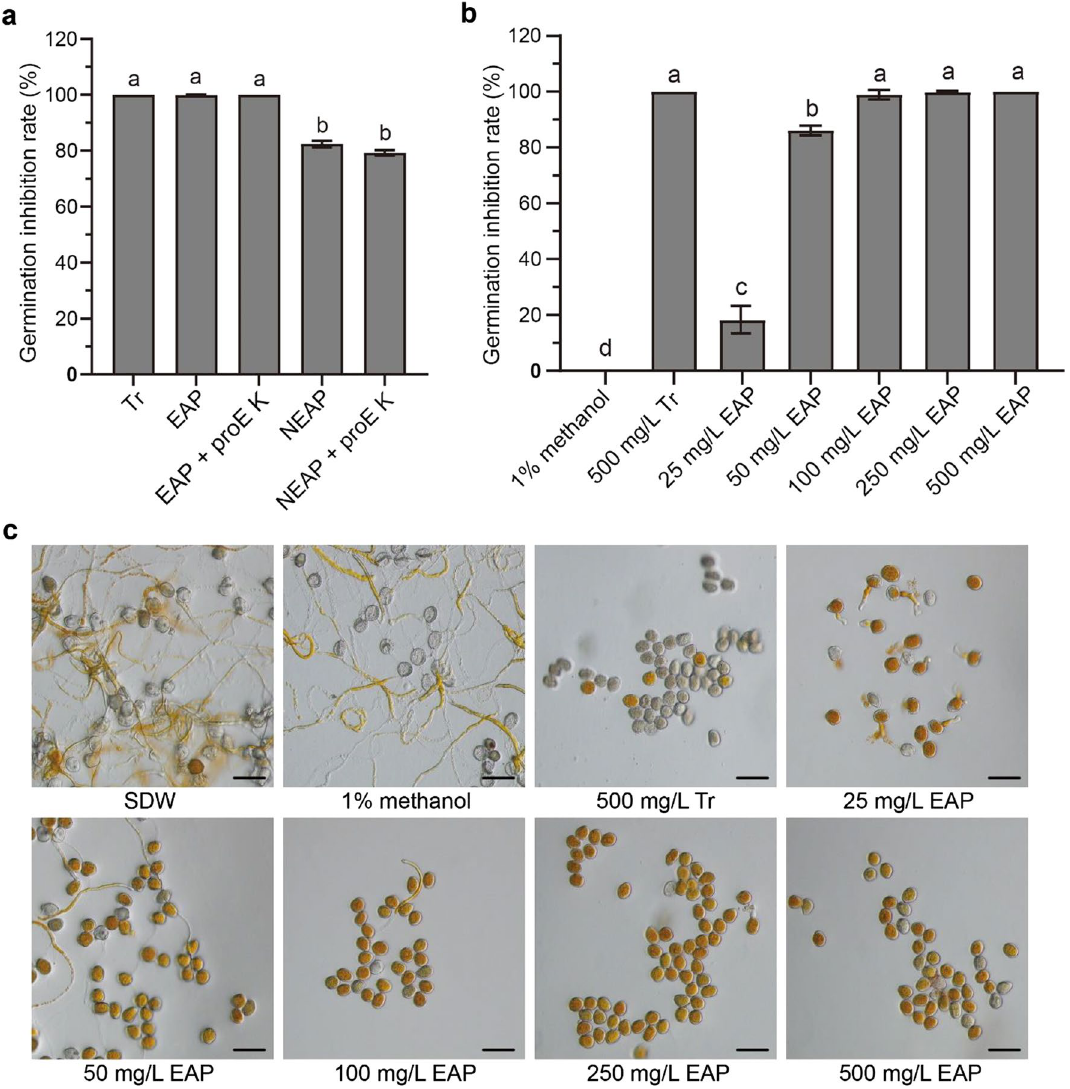
Fig. 6 Effect of different concentrations of EAP solution on the germination of Pst urediniospores. a Comparison of the inhibition rate of urediniospore germination by EAP and NEAP before and after treatment with proE K. Values in the chart are mean range tests, different lowercase letters indicate differences with significance level 0.05. b Inhibition rate of urediniospore germination by incubating with different concentrations of EAP solution for 12 h at 9°C in the dark. c Morphology of urediniospores in the above treatments under the optical microscope. Bars 50 μm. EAP, ethyl acetate phase active substance; NEAP, non-ethyl acetate phase active substance; proE K, proteinase K. Sterile = distilled water (SDW), 1% methanol, and Tr were used as